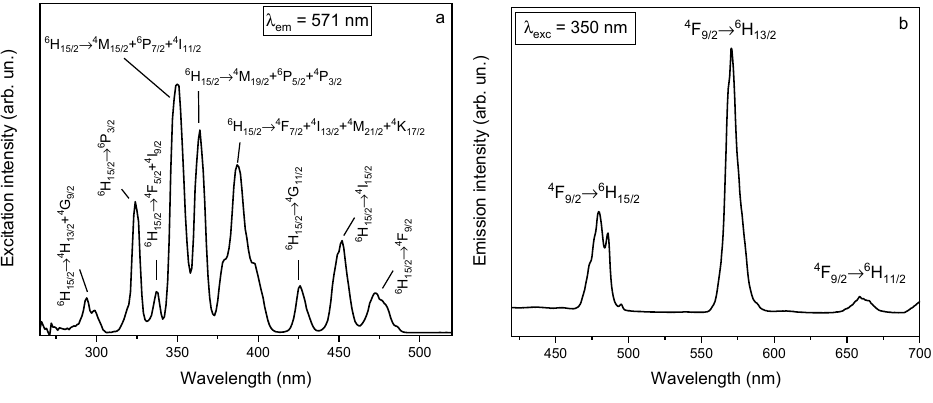
Figure 8. Excitation ( a ) and emission ( b ) spectra of Ca 9 Dy(PO 4 ) 7 .